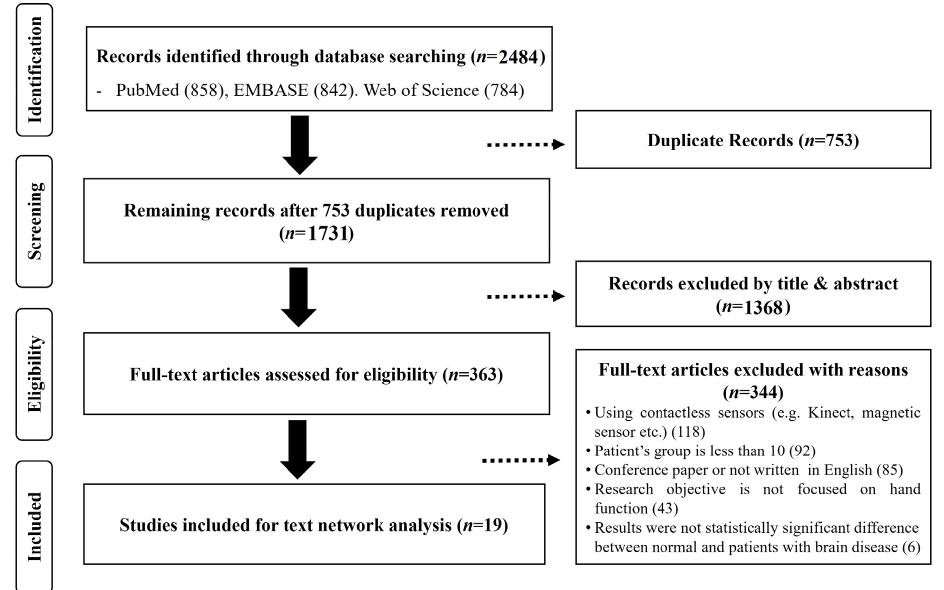
Figure 1. Flowchart of literatures selection process.